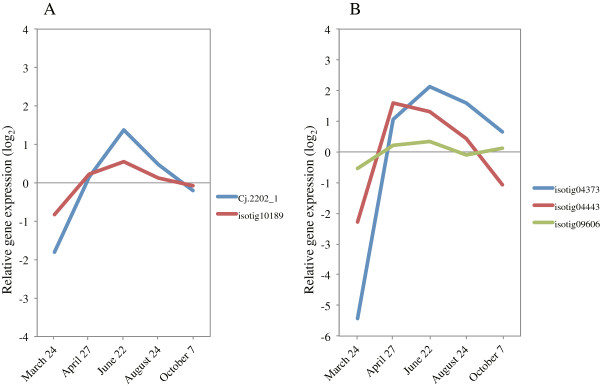
Expression of KORRIGAN1 and COBRA in cambial region during xylem formation. A)KORRIGAN1 (KOR1). B)COBRA (COB). The individual targets are summarized in Additional file 3. All expression data are presented on a log2 scale.